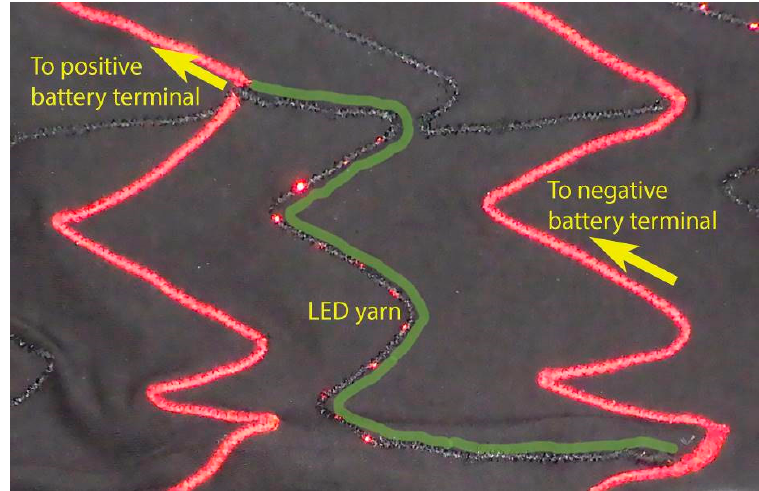
Figure 4. Circuitry on the costume: The LED-yarn is highlighted in green. Each LED-yarn contained 12 LEDs and was connected to two red E-yarns: One red E-yarn was connected to the positive terminal of a battery, and the other to the negative terminal.